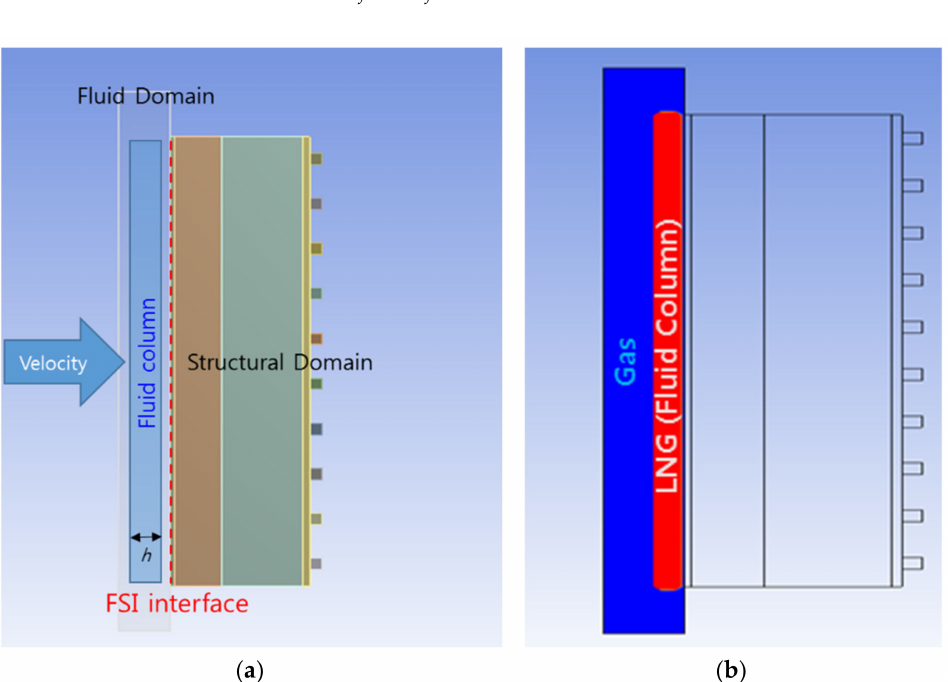
Figure 14. Local FSI model using a fluid column: ( a ) schematic configuration of the FSI model; ( b ) volume fraction of the multi-phase in fluid